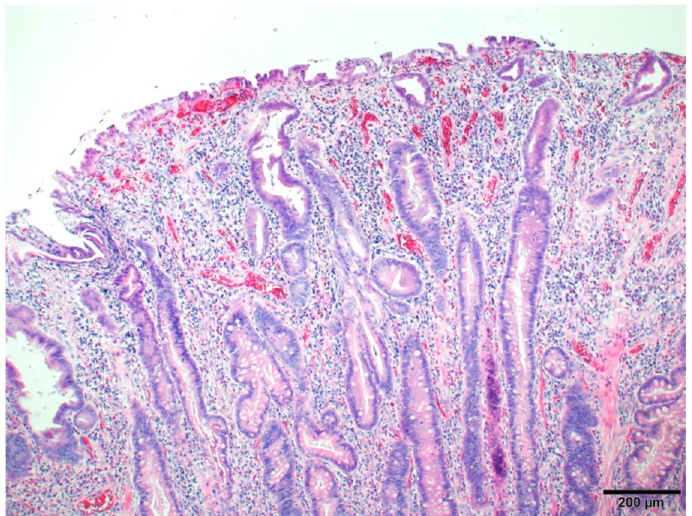
Figure 3. The histopathological findings of the resected polyp (hematoxylin and eosin staining). The histology shows mixed findings of dilated and serrated glandular ducts with partial granulation, consistent with a hamartomatous polyp.